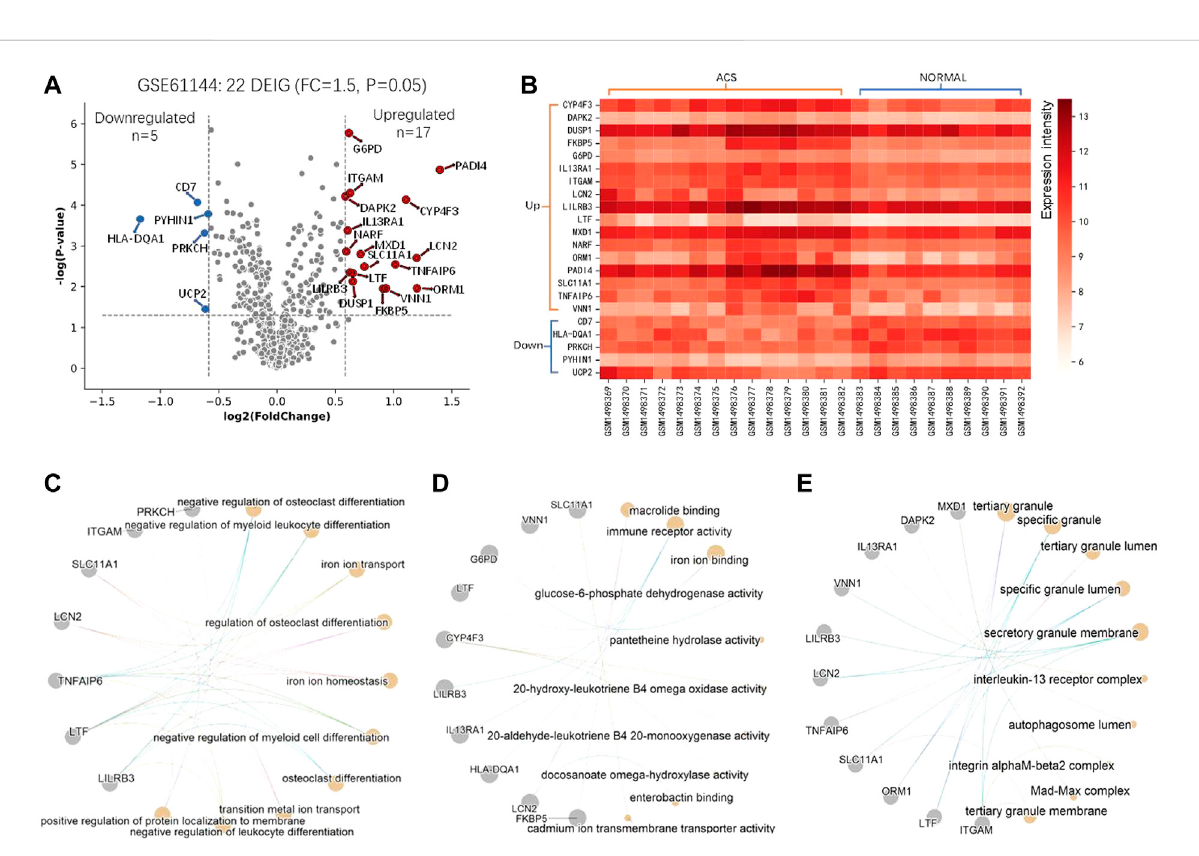
FIGURE 2 Differential and functional analysis of DEIGs. (A) Identi fi cation of differentially expressed IMRGs. (B) Heatmap of the identi fi ed DEIGs. Enriched functions of the DEIGs in the ontology of Biological Process (C) , Molecular Function (D) , and Cell component (E)